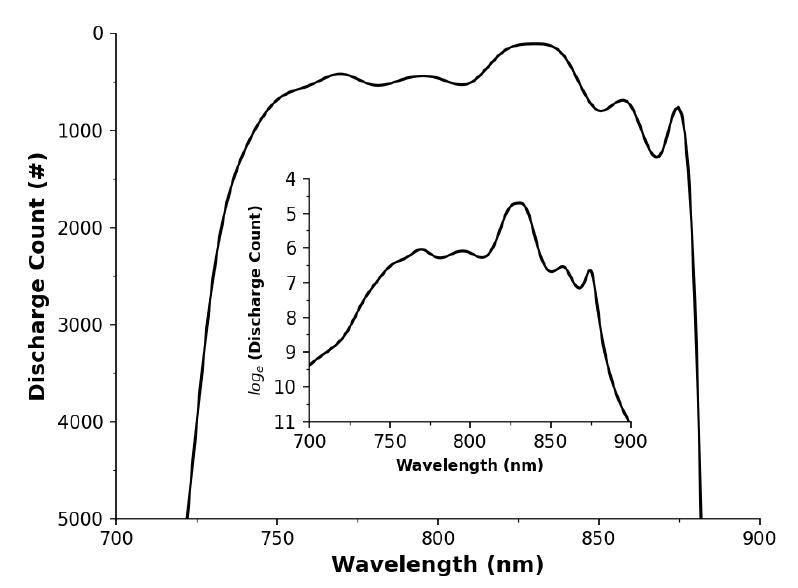
Figure A2. Spectral sensitivity of the LED when measured in PEDD discharge counter mode from 5000 to 0. Inset: Full response from 0 to 2 26 on a log scale. Figure A3: These measurements of the counts before the LED output voltage dropped